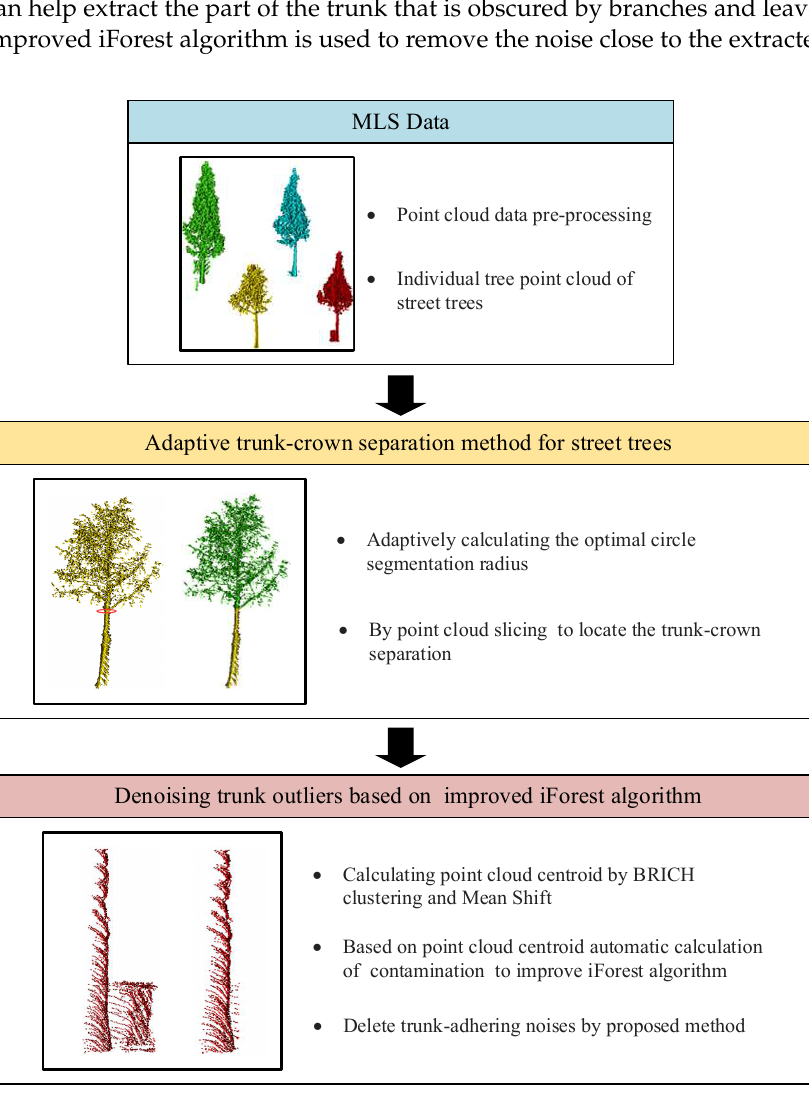
Figure 2. The workflow of the proposed method.